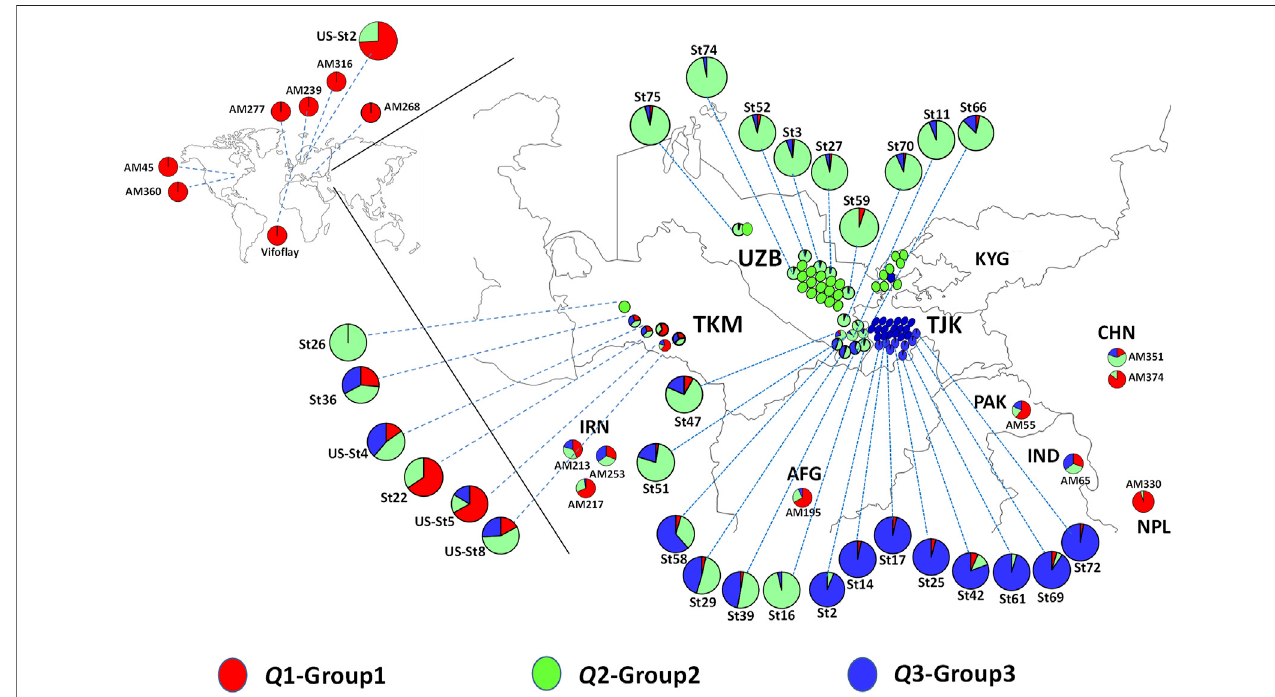
FIGURE 4 | Geographic distribution of accessions of Spinacia oleracea and S. turkestanica that form three groups based on single nucleotide polymorphisms (SNPs) detected in the plants collected from these locations. Red represents the proportion of membership of a genotype from the Q 1 group, comprised primarily of S. oleracea , and green and blue represent the proportions of membership in two groups, Q 2 and Q 3, respectively, of S. turkestanica . The admixed accessions are color- coded proportionally to the degree of ancestry from Q 1, Q 2, and Q 3 groups. The S. turkestanica accessions consist of mixed ancestry, based on < 95% membership in the Q 2 or Q 3 subpopulations. AFG, Afghanistan, CHN, China; IND, India; IRN, Iran; KYG, Kyrgyzstan; NPL, Nepal; PAK, Pakistan; TJK, Tajikistan; TMK, Turkmenistan, and UZB, Uzbekistan. AM, Association mapping panel of S. oleracea accessions obtained from the United States Department of Agriculture National